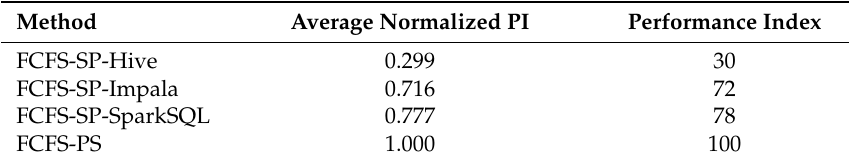
Table 15. Average normalized performance index for Case